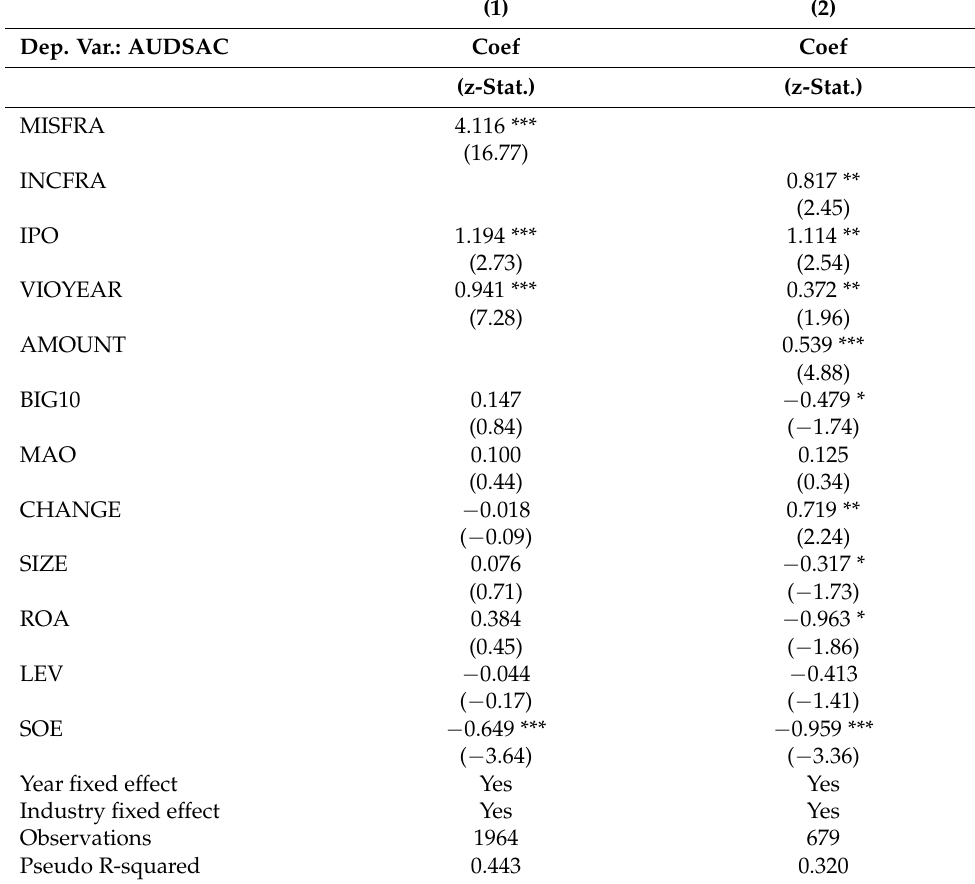
Table 7. Regression results of the PSM